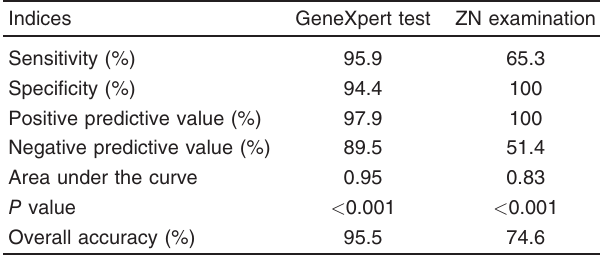
Table 4 Accuracy of GeneXpert test and Ziehl – Neelsen